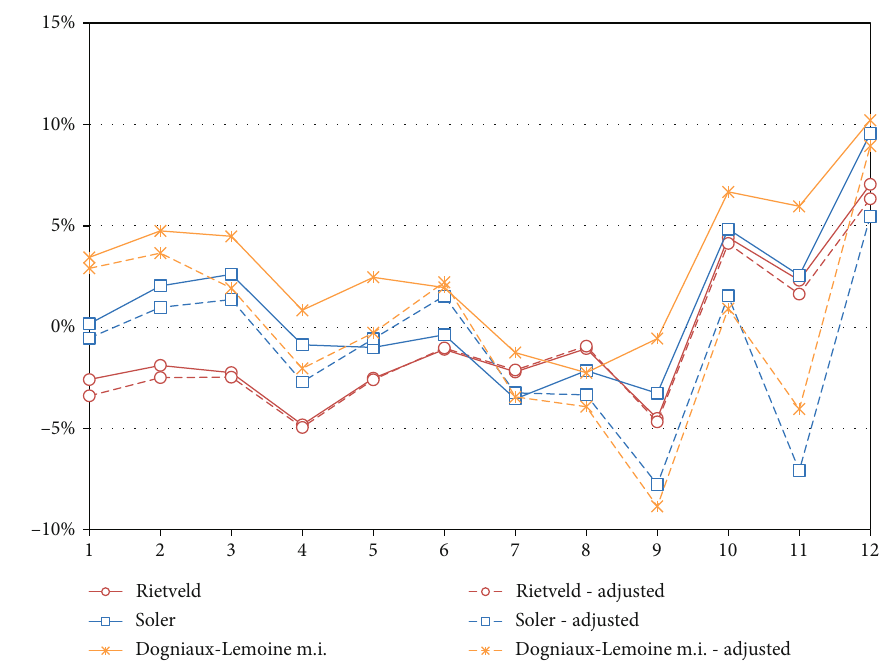
Figure 2: Comparison of percentage error of original and adjusted models for Kri ž